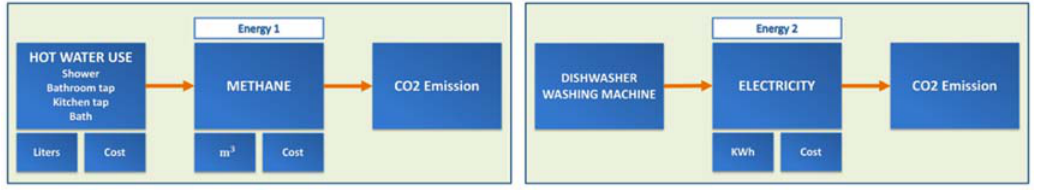
Figure 4. Scheme defining the energy usage and the consequent CO 2